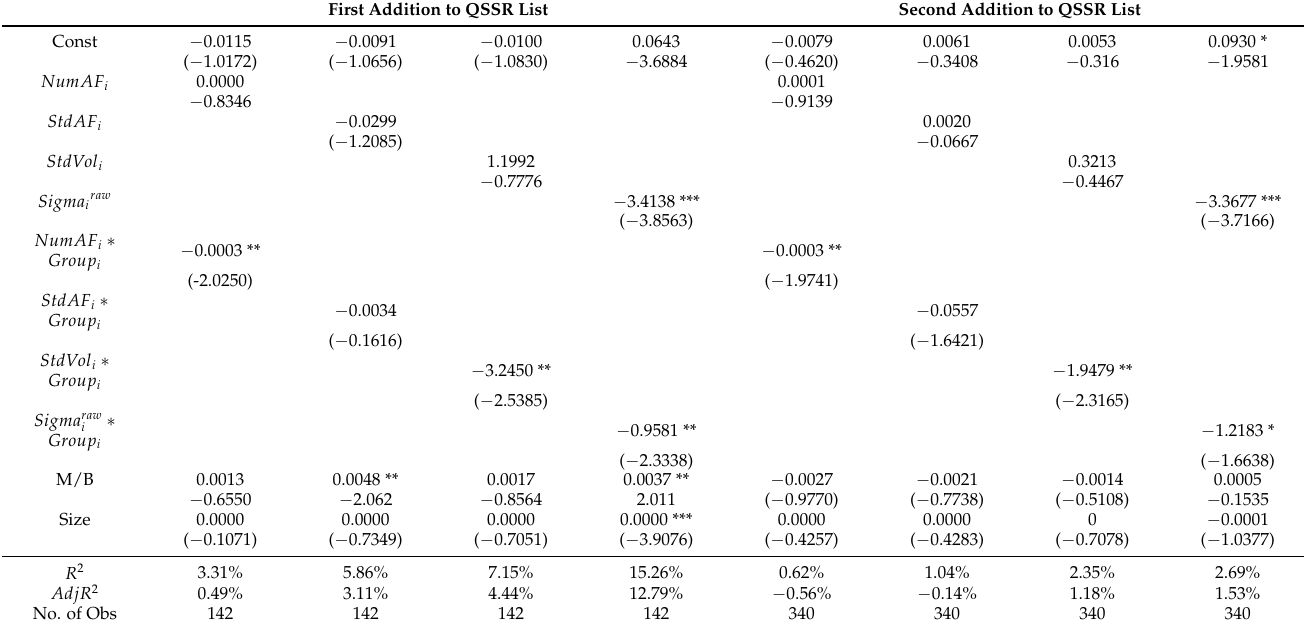
Table 11. Cross-sectional regressions of CAR(0,10) on proxies of investor heterogeneity. CAR i ( 0,10 ) is the dependent variable. Sigma raw is the standard deviation of daily ARs; StdVol i is the standard i deviation of daily turnover; NumAF i is the number of analysts following stock i; StdAF i is the accuracy of analysts’ forecast of earnings per share.